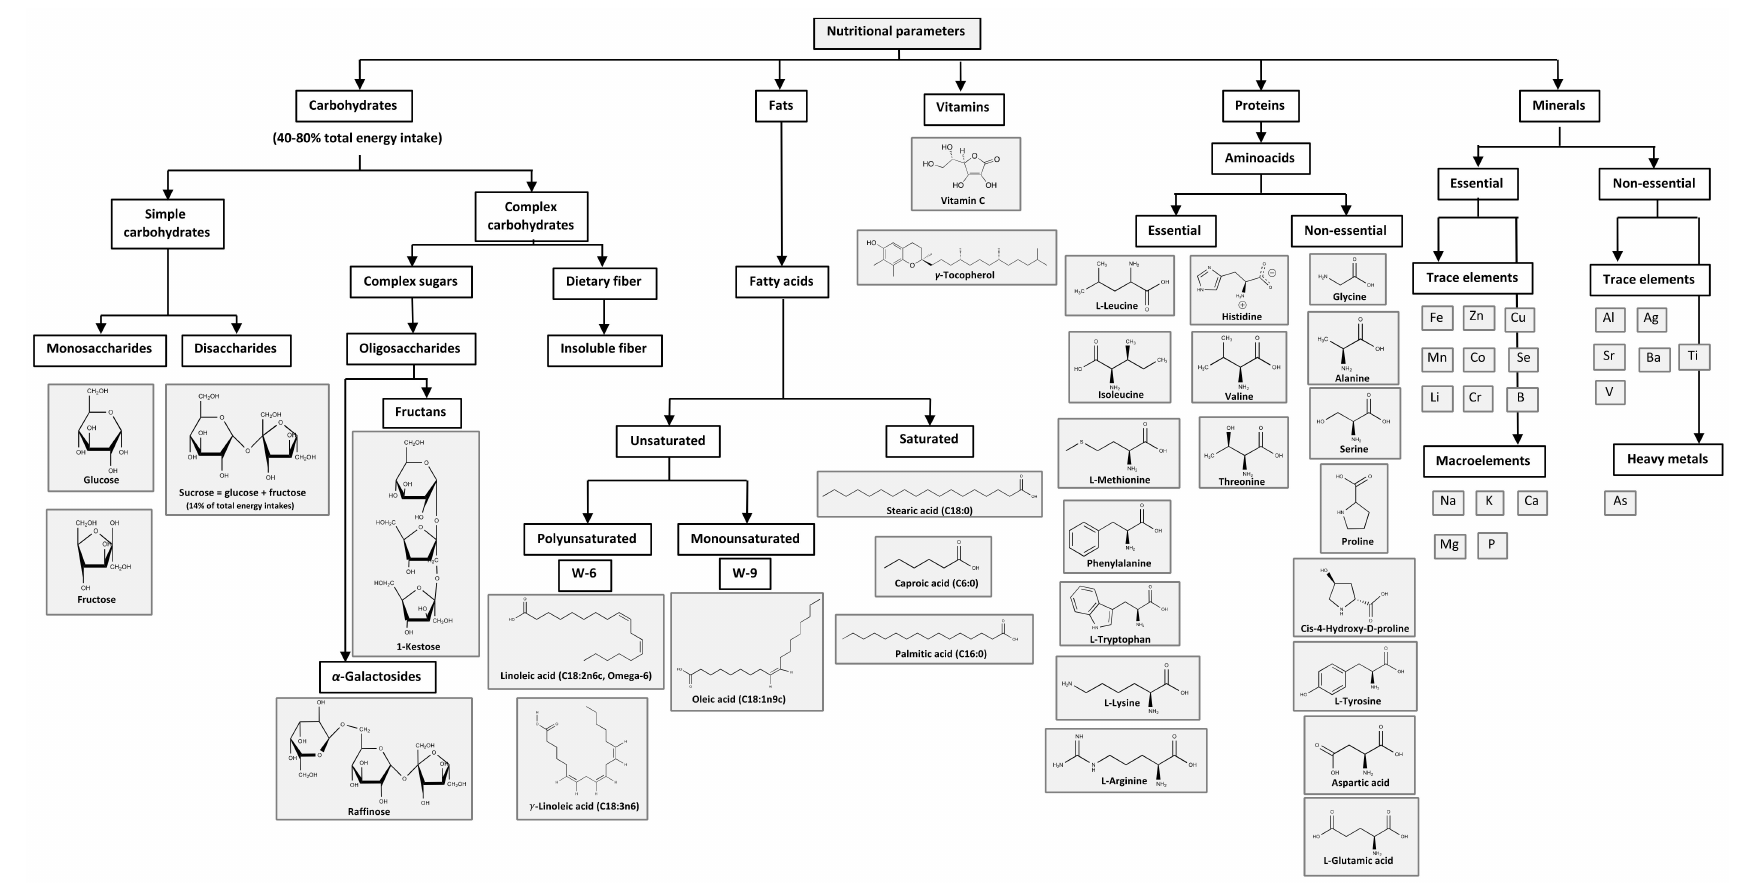
Figure 2. Nutritional parameters, carbohydrates, fats (fatty acids), proteins (amino acids), vitamins, and minerals observed in carob products, coming from the carob pulp or produced during the different steps of carob product